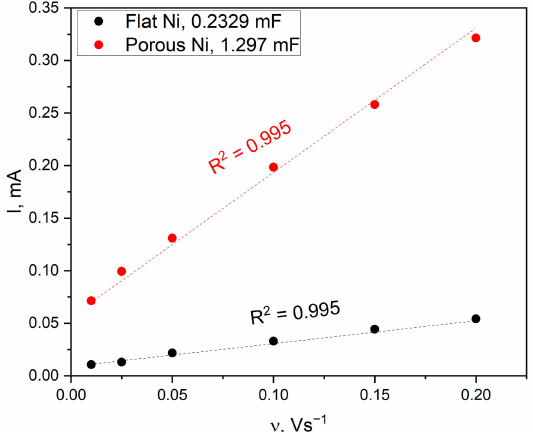
Figure 11. Double-layer capacitance of Ni flat (black) and porous Ni sample (red) determined by cyclic voltammetry measurements in the non-Faradaic potential regions with different sweep rates.